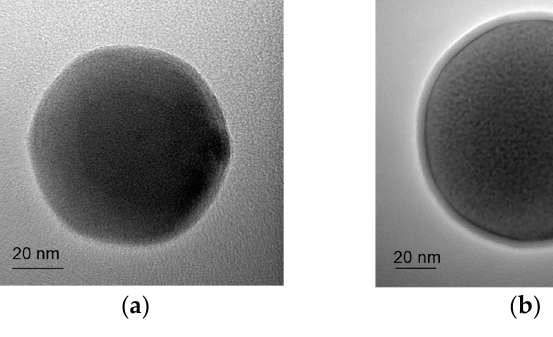
Figure 1. TEM images of the Al ( a ) и and Al/Ag ( b ) nanoparticles and nanoparticle size distribution curve ( c ).